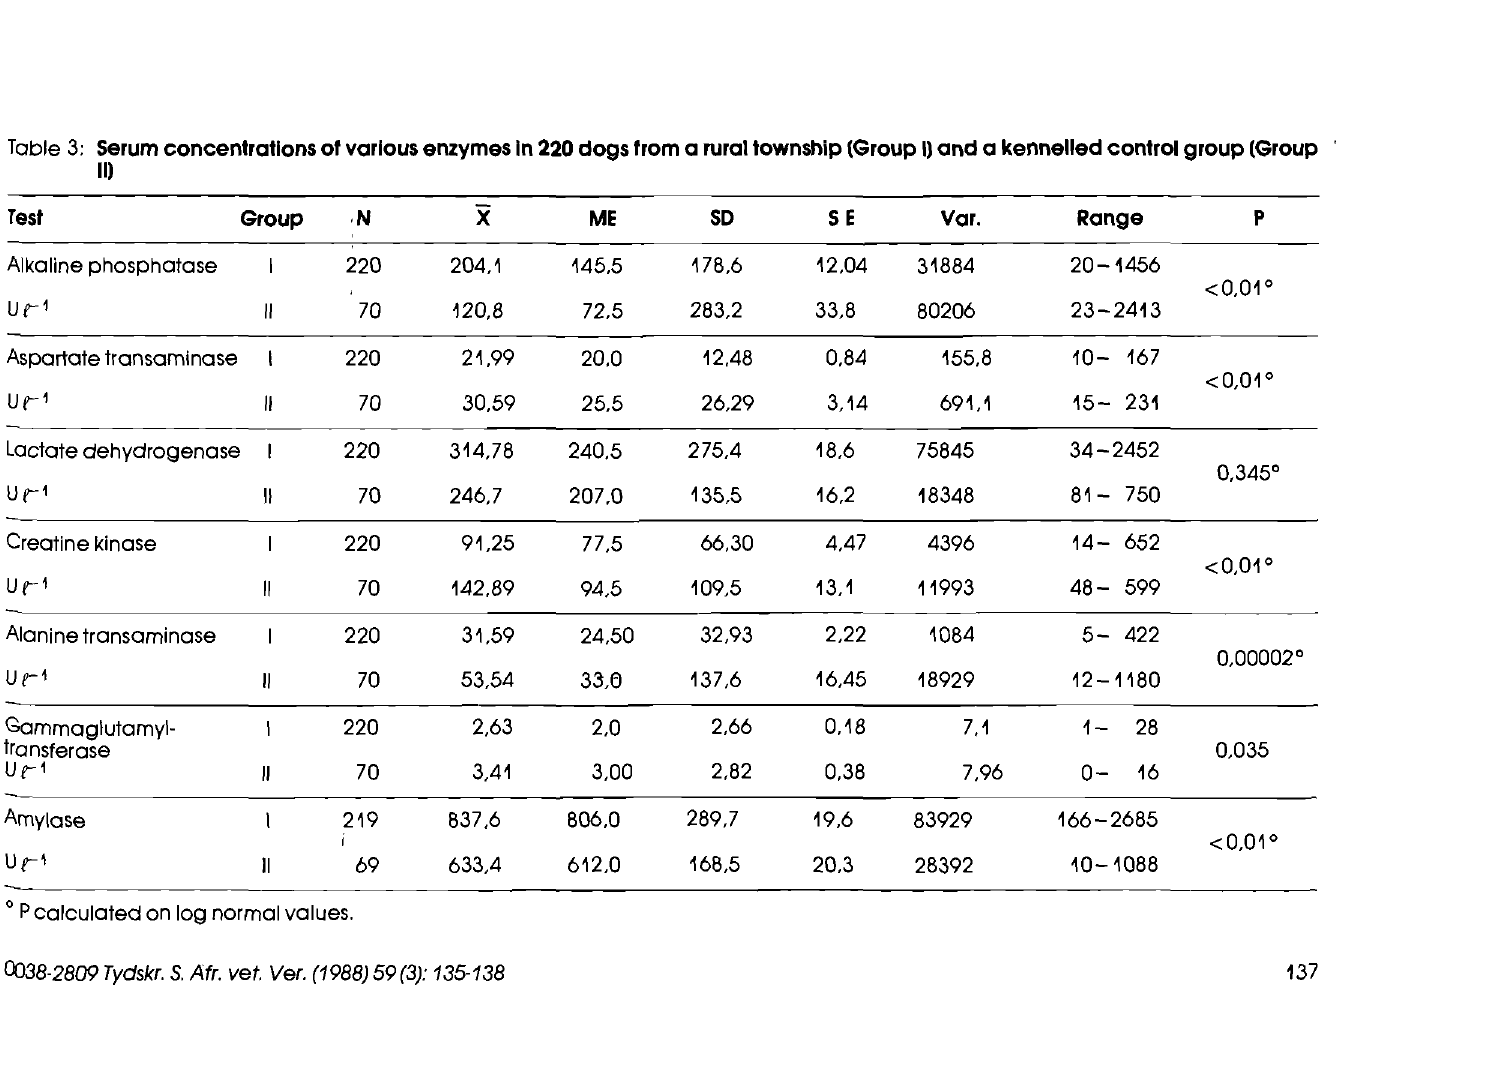
Table 3: Serum concentrations of various enzymes in 220 dogs from a rural township (Group I) and a kennelled control group (Group II) Test Alkaline phosphatase Ur-i Aspartate transaminase Ur-i Lactate